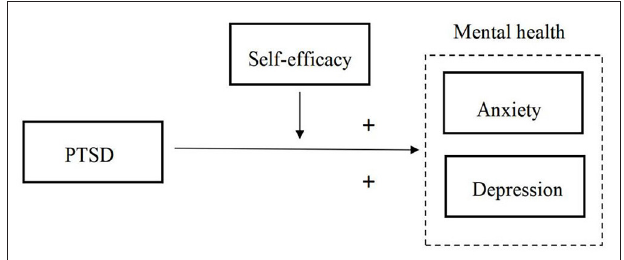
FIGURE 1 | Theoretical hypothesis